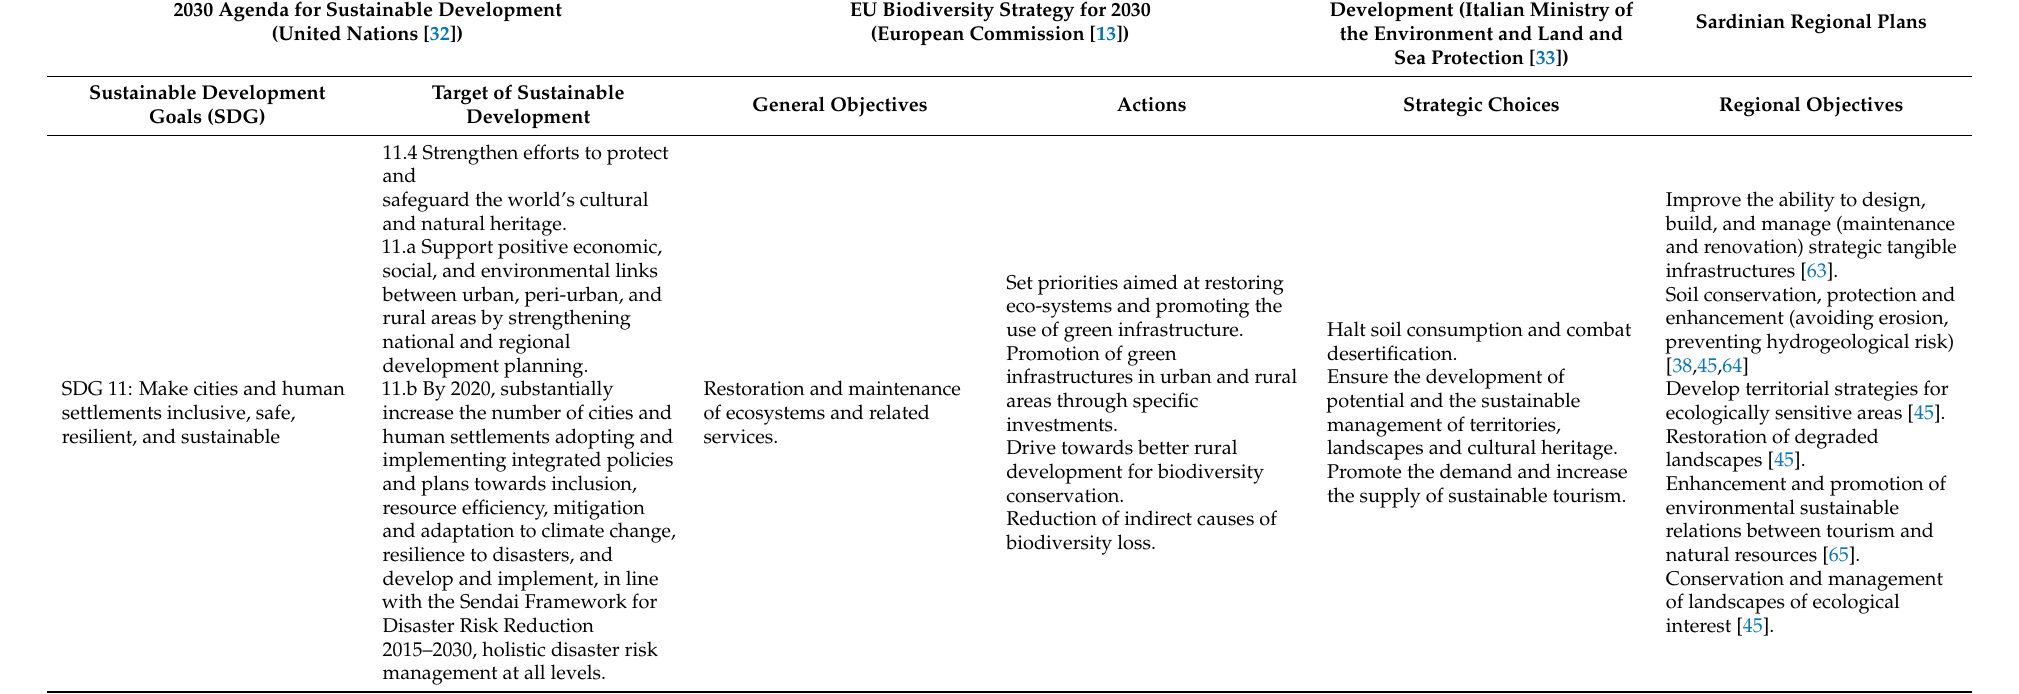
Table A1. Consistency check. The scrutiny of the 2030 Agenda [32] allowed the identification of sustainability objectives at a global level (Sustainable Development Goals, SDG) that can be achieved by implementing a GI (first column, SDG n. 11, 13, and 15). The second column shows the targets of the 2030 Agenda, which are linked to each SDG and the functions and purposes of the GI (such as the provision of ecosystem services). The third column includes the objectives of the European Biodiversity Strategy 2030 [13]. The fourth column refers to the actions envisaged by the European Biodiversity Strategy 2030 concerning the adoption of Nature Based Solutions, which imply the planning, design, and implementation of GIs, or their components, to meet the objectives of the Strategy. The fifth column shows the strategic choices of the National Strategy for Sustainable Development [33]. The last column includes objectives defined by the regional plans. 2030 Agenda for Sustainable Development (United Nations